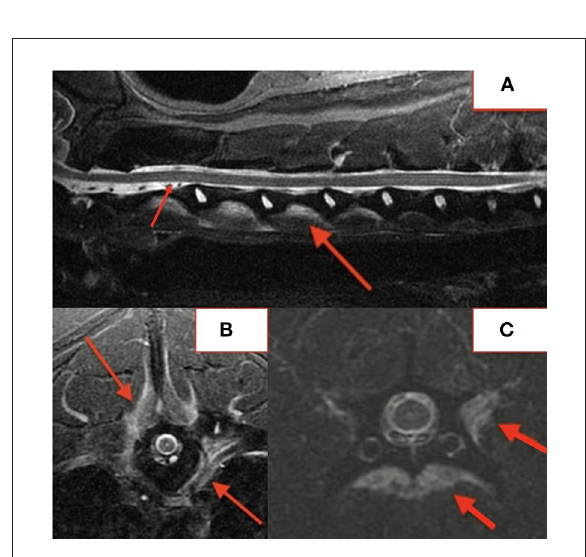
FIGURE4 MRI STIR cervical sagittal (A) and axial paravertebral lesions at T6 (B) and C5 (C) .